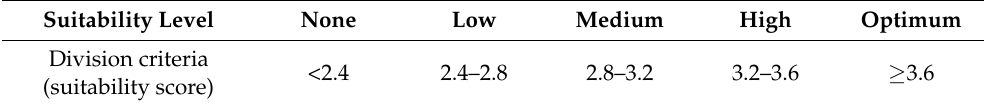
Table 2. Characteristics of rural settlements based on different suitability